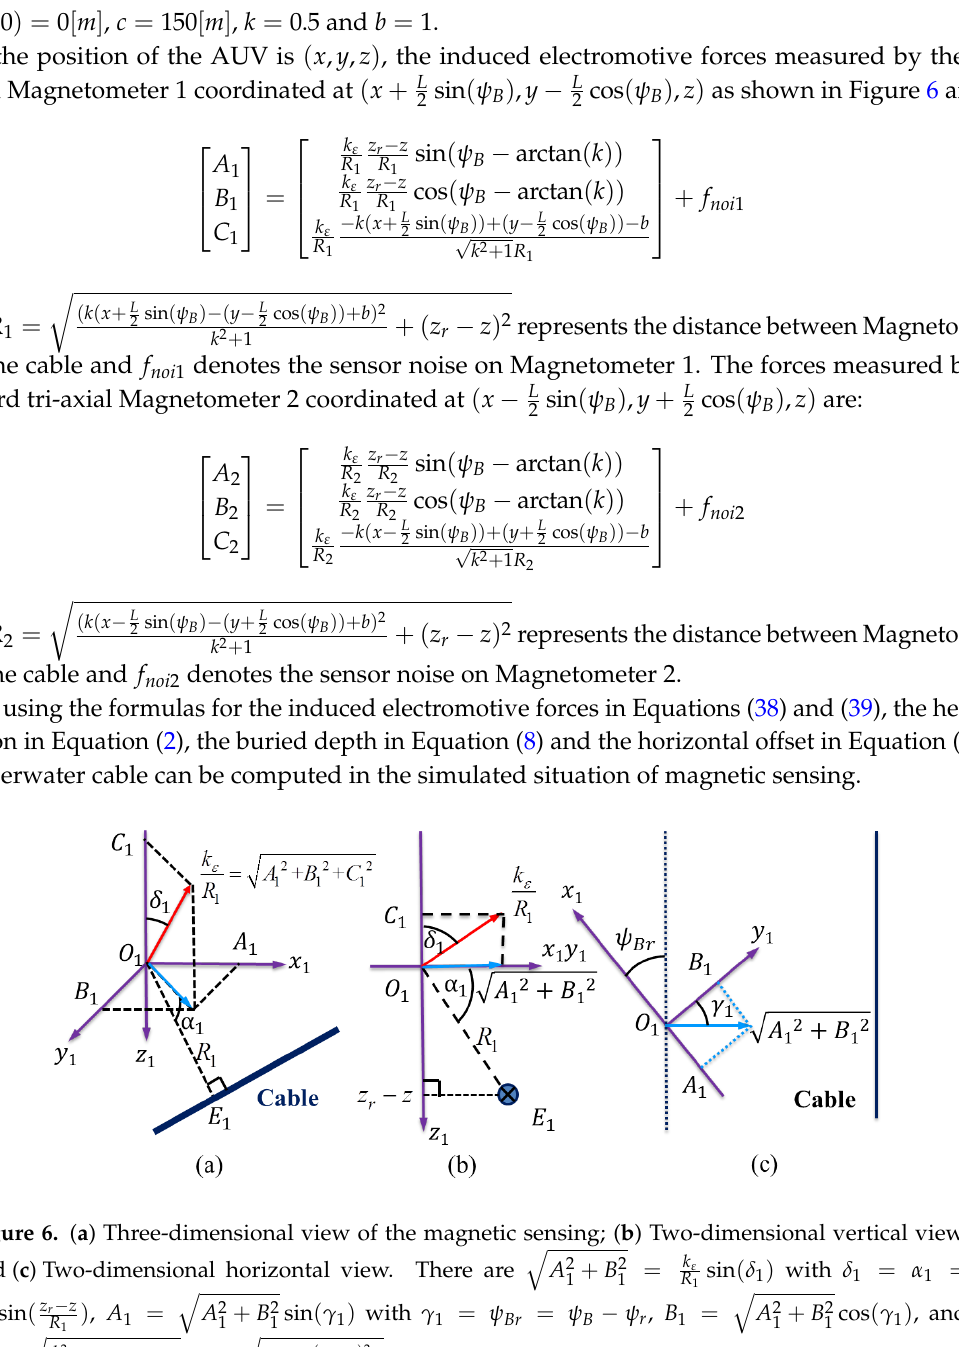
(cid:113) + B 2 = k ε A 2 sin ( δ 1 ) with δ 1 = α 1 = R 1 1 1 (cid:113) + B 2 A 2 cos ( γ 1 ) , and 1 1